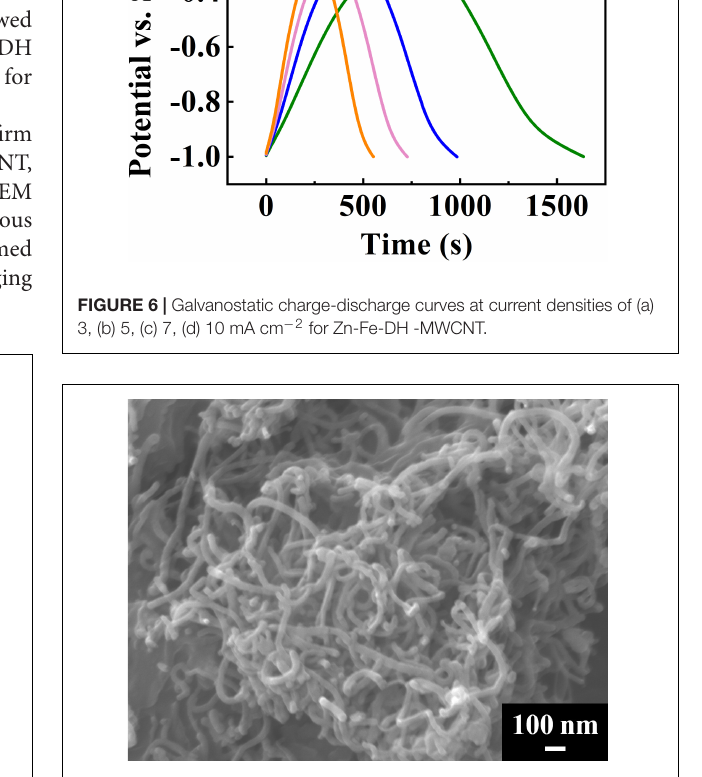
FIGURE 7 | SEM image of PPy-MWCNT